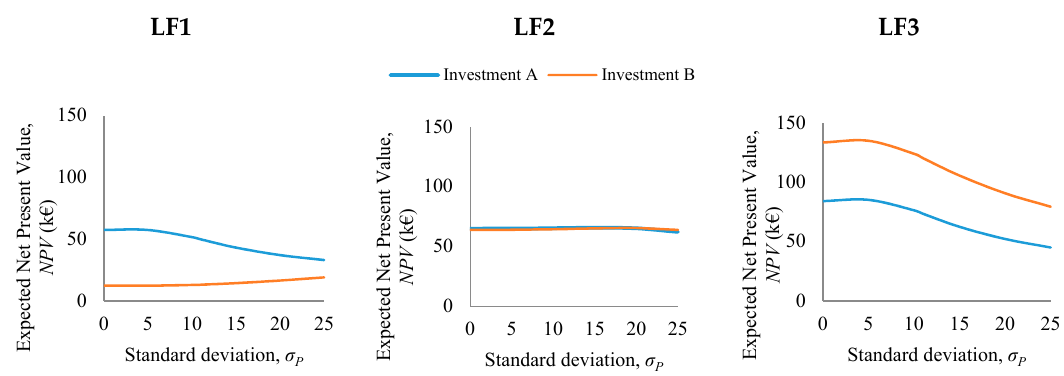
Figure 8. Expected NPV of the investments in “SEC reduction” (Investment A) and “SEC levelling” (Investment B) for different standard deviation values of the normal distributions defining the production rate for the three load factors investigated.